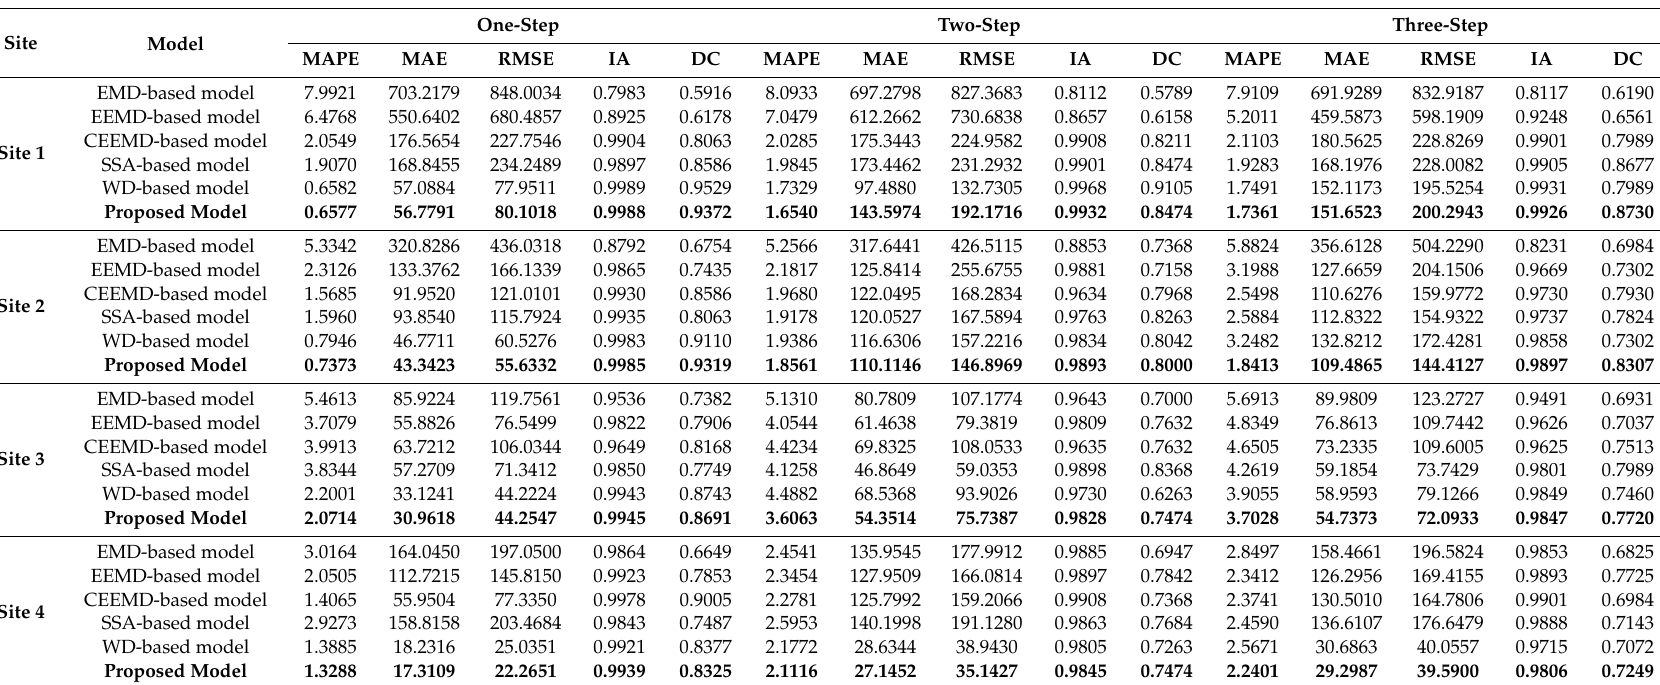
Table 6. The models with di ff erent data preprocessing